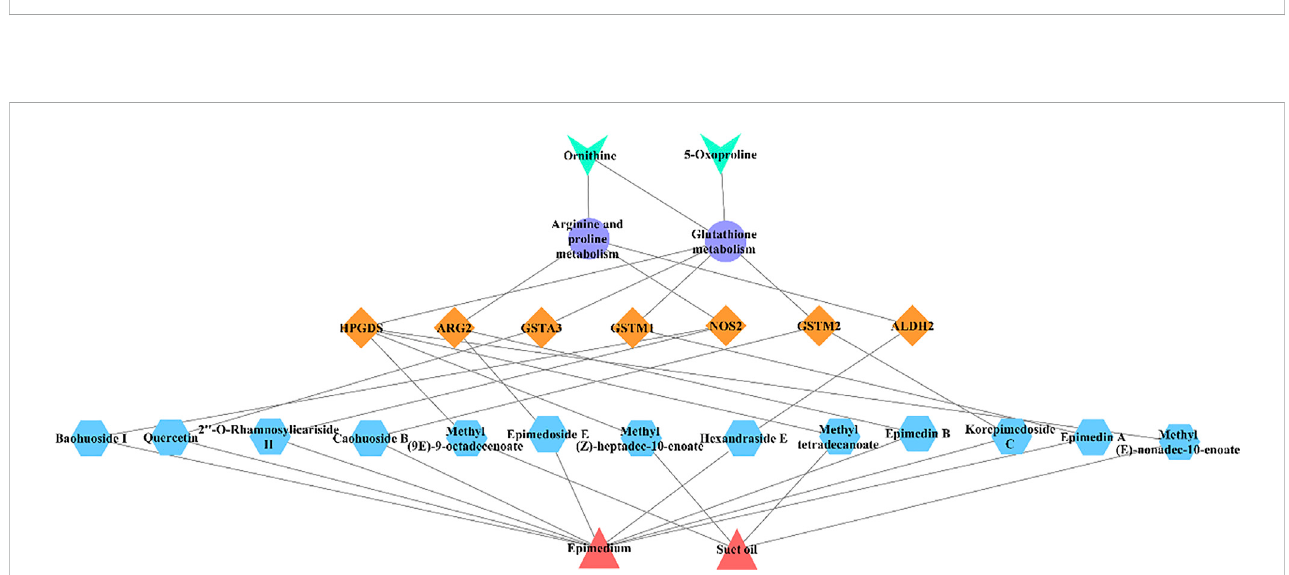
FIGURE 11 Epimedium fried with suet oil regulates differential gene expression associated with kidney yang de fi ciency. All genes expression were examined by RT- qPCR and normalized to GAPDH expression. Data represent mean ± SD for at least three independent experiments. Compared with the N group, * p < 0.05, ** p < 0.01; compared with the M group # p < 0.05, ## p <